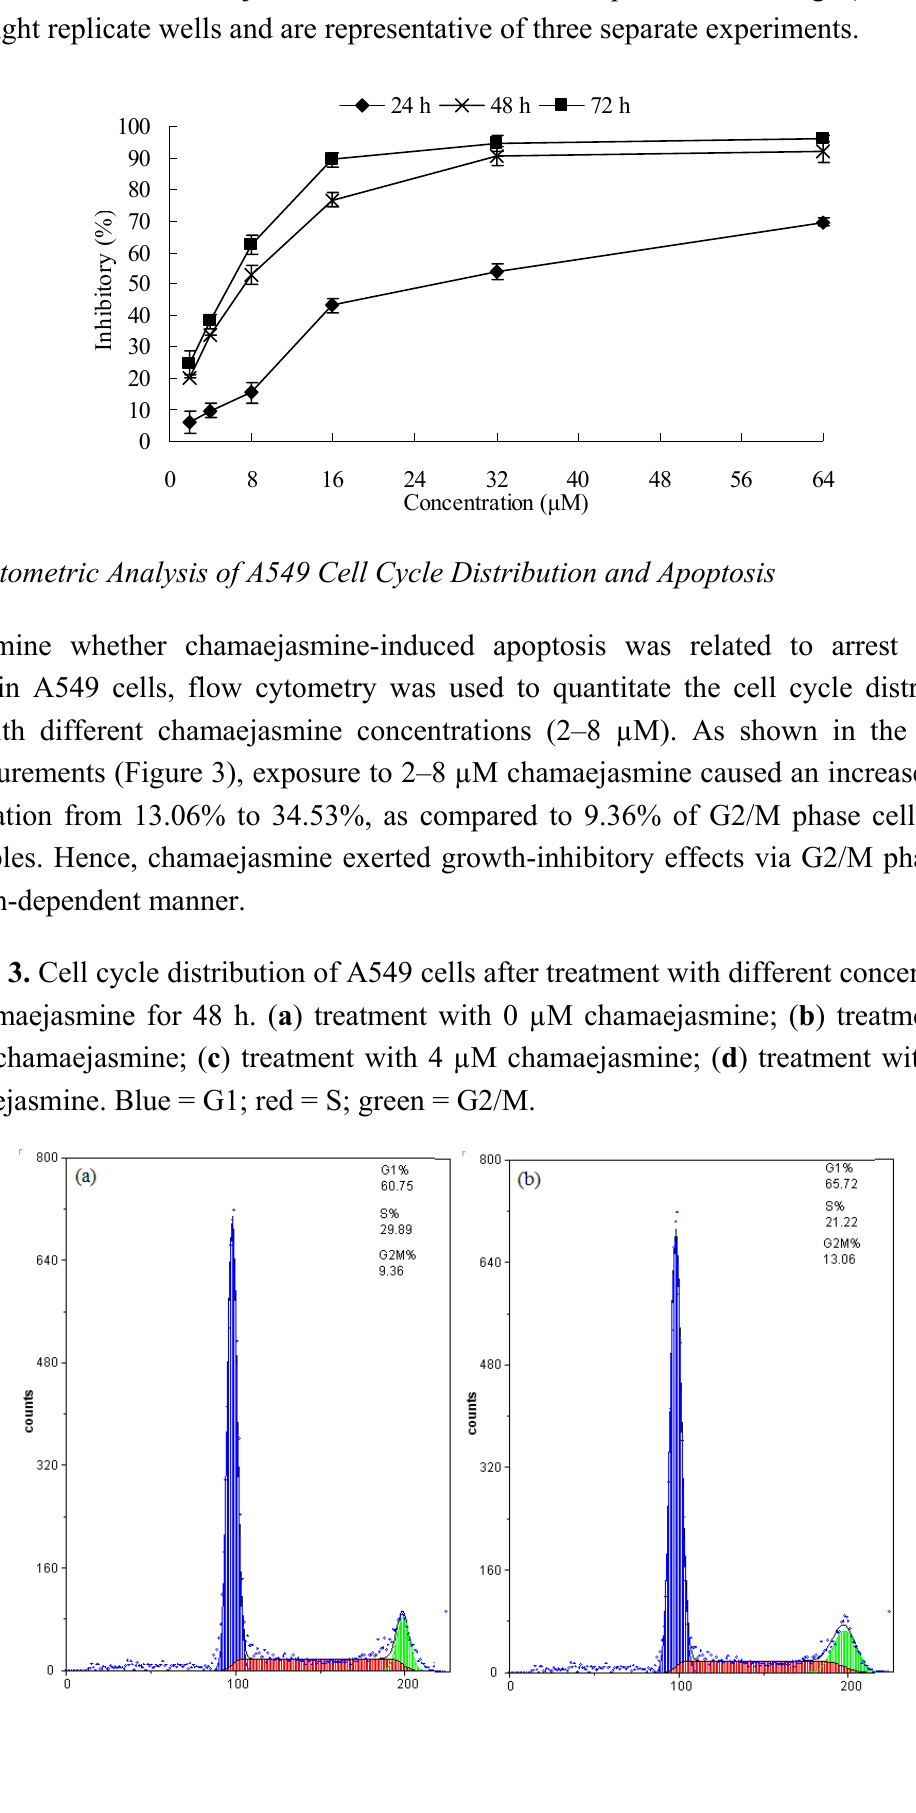
Figure 2. Effect of chamaejasmine towards A549 cells as determined by the MTT assay. The values for each chamaejasmine concentration tested represent the average (mean ± S.D.) from eight replicate wells and are representative of three separate experiments.